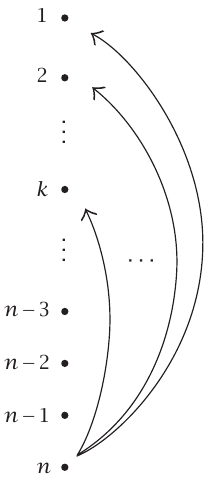
Figure 3.1 Tournaments in Theorem